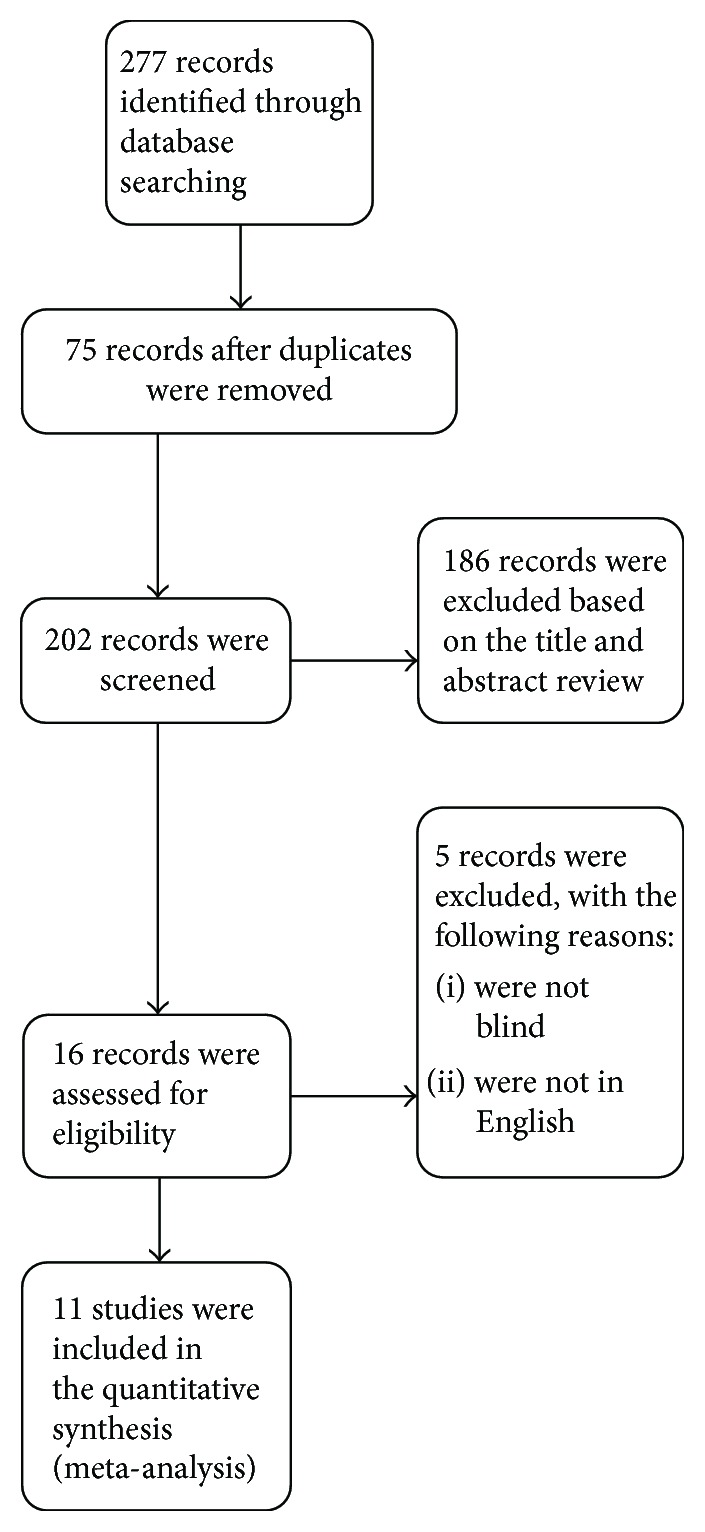
PRISMA flow diagram of included and excluded trials.